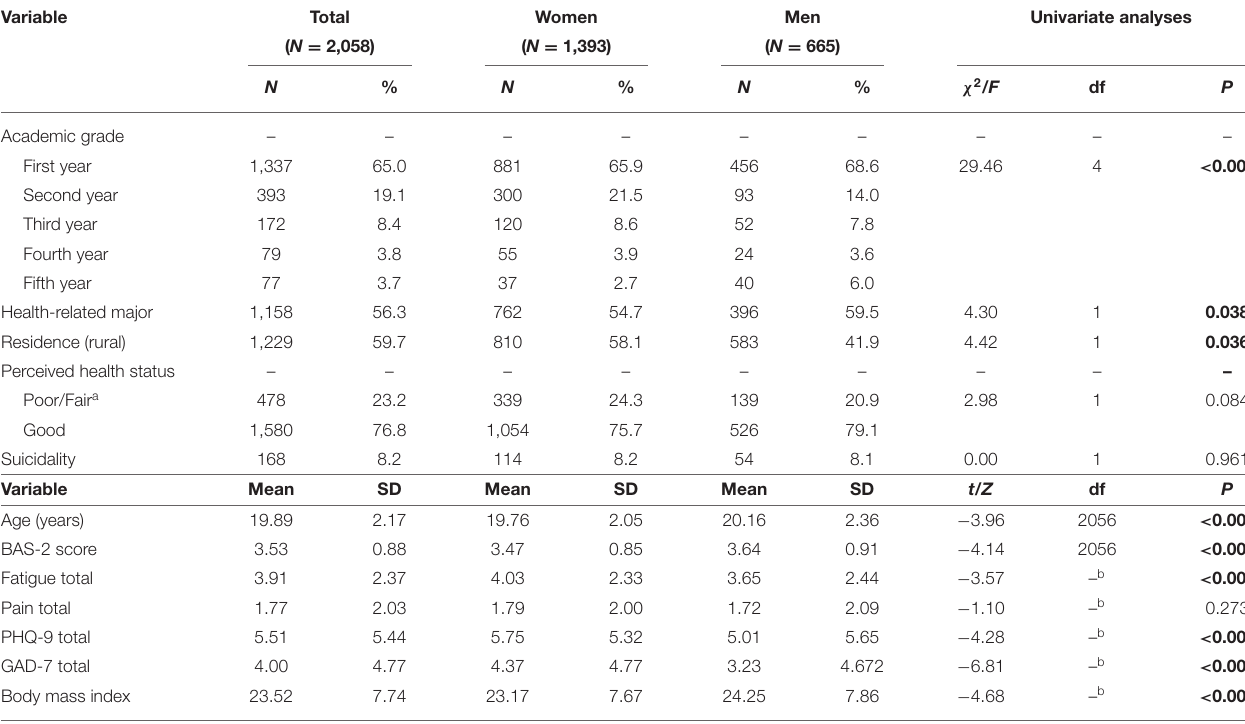
TABLE 1 | Socio-demographical and clinical characteristics of the whole sample and by gender. Variable Total Women Men Univariate